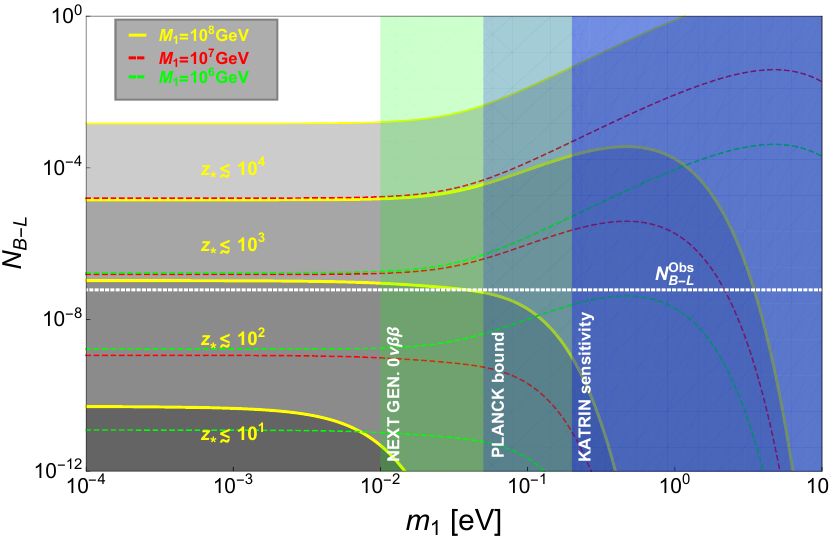
Figure 1 . Eos: ω = 1 . The yellow, red and green lines correspond to the lightest RH mass M 1 = 10 8 , 7 , 6 GeV. For M 1 = 10 7 , 6 we do not show the lines corresponding to z ∗ = 10 1 . We take M 3 = M 1 /z in GeV, M 2 = 10 − 1 M 3 GeV, x ij = π/ 4 , y ij = 10 − 1 and two mass-squared differences are at their best-fit